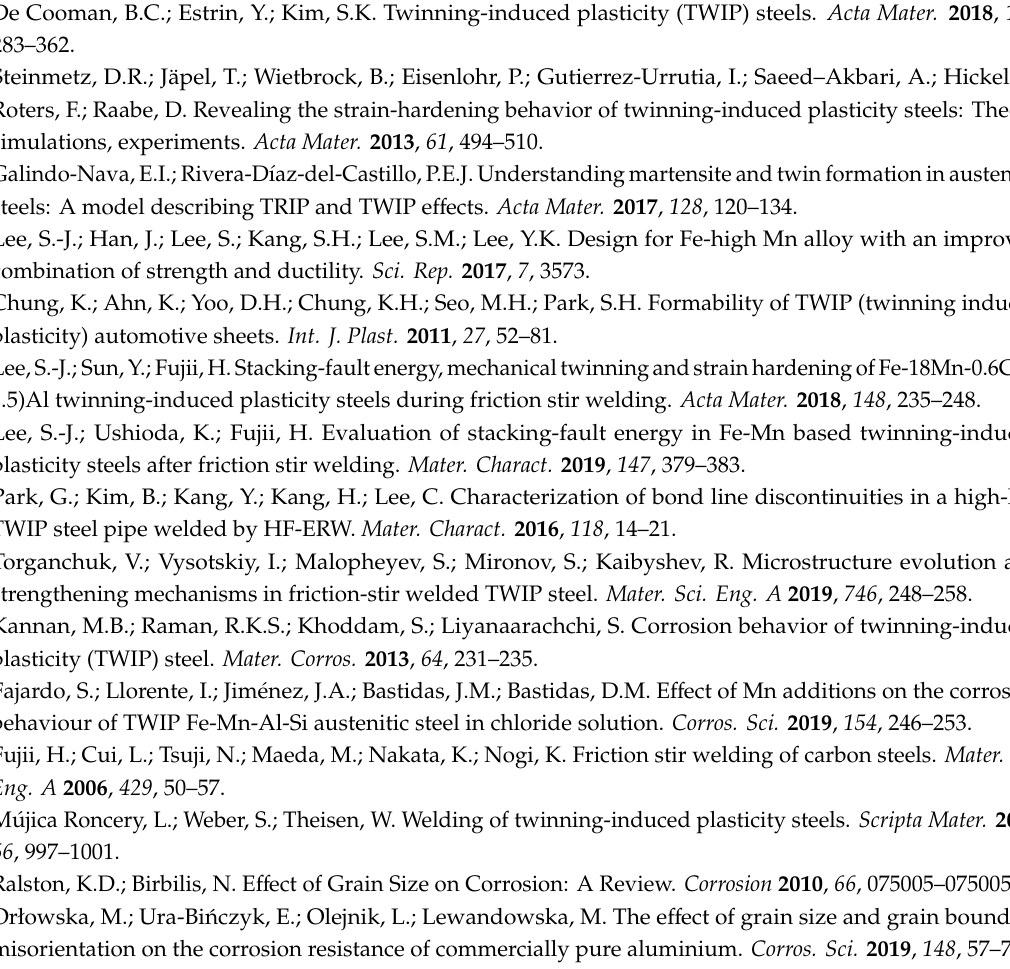
Figure S1: Optical micrograph of the friction-stir-welded Fe–30Mn–3Al–3Si (wt.%) twinning–induced plasticity (TWIP) steel sheet and both base metal and stir zone samples milled area for the corrosion tests. Figure S2: Pole figures of (a) base metal and (b) stir zone in Fe–30Mn–3Al–3Si (wt.%) TWIP steel. Figure S3: Selected model of equivalent electrical circuit used to fit impedance